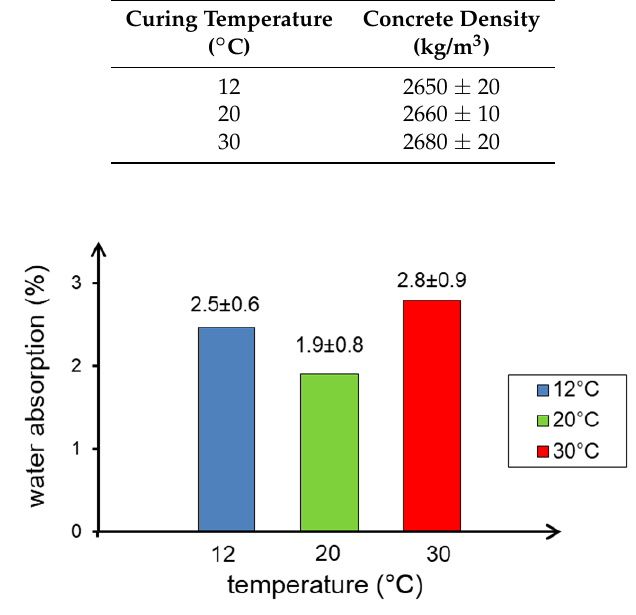
Figure 7. Water absorption of concrete samples depending on concrete curing temperature.